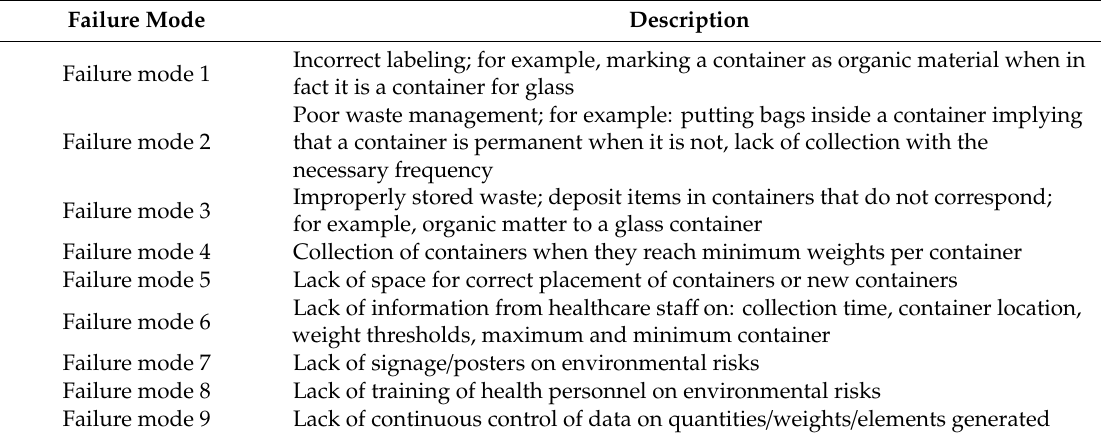
Table 5. Nuclear Medicine Department segregation failure modes.